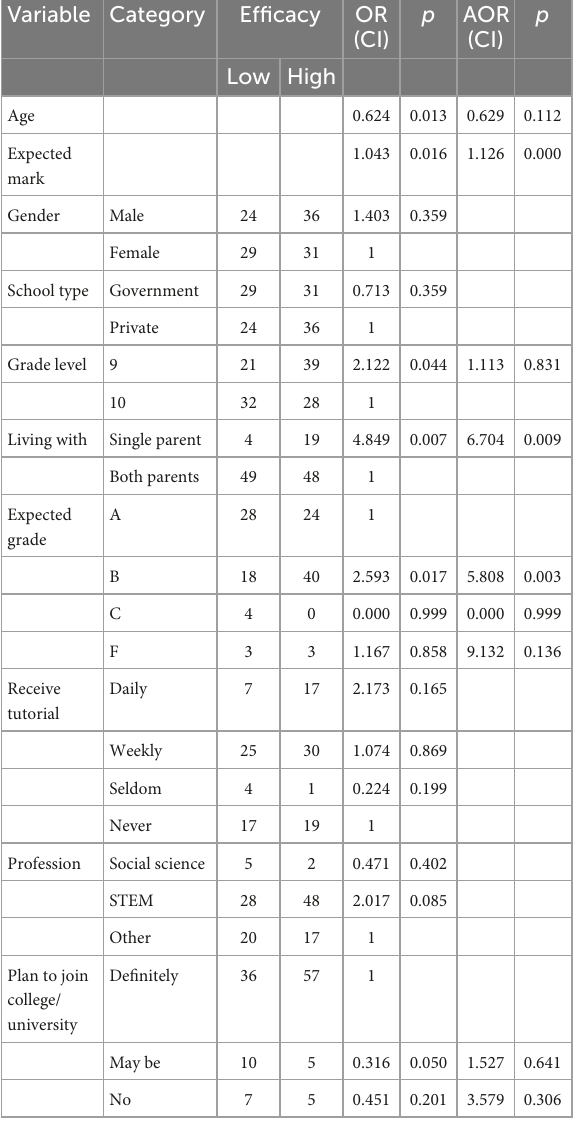
TABLE 6 Bivariate and multivariate logistic regression results of predictor variables. Variable